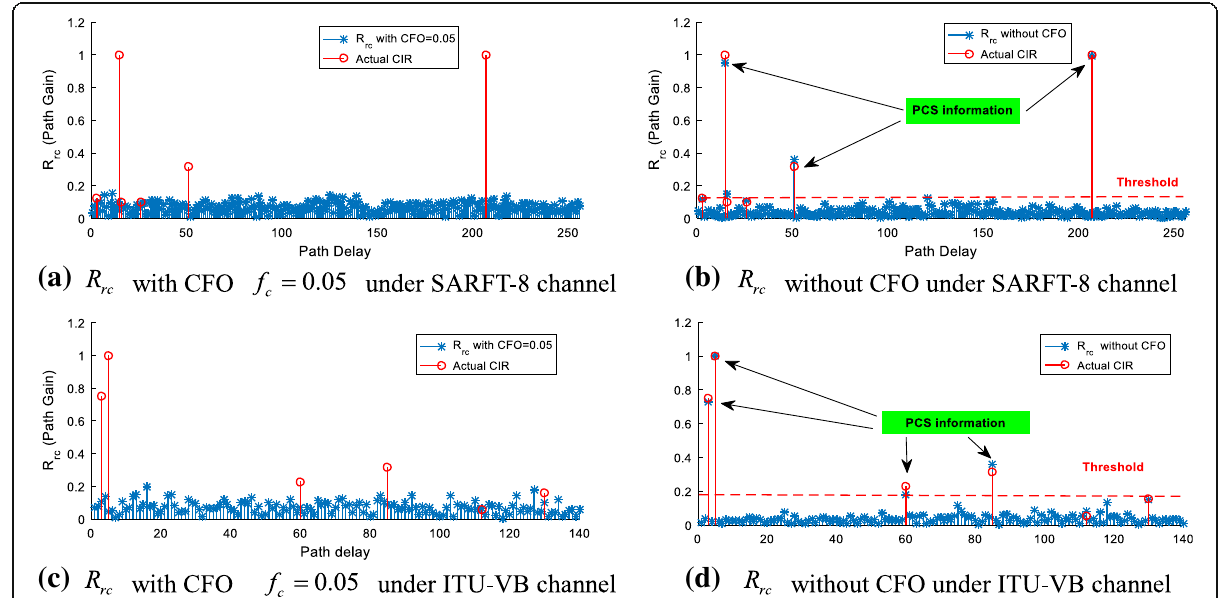
Fig. 3 The CFO influence on R rc (the cross-correlation between local PN sequence and received signal) in 16×16 MIMO-OFDM system with f max =20 HZ and SNR=5 dB